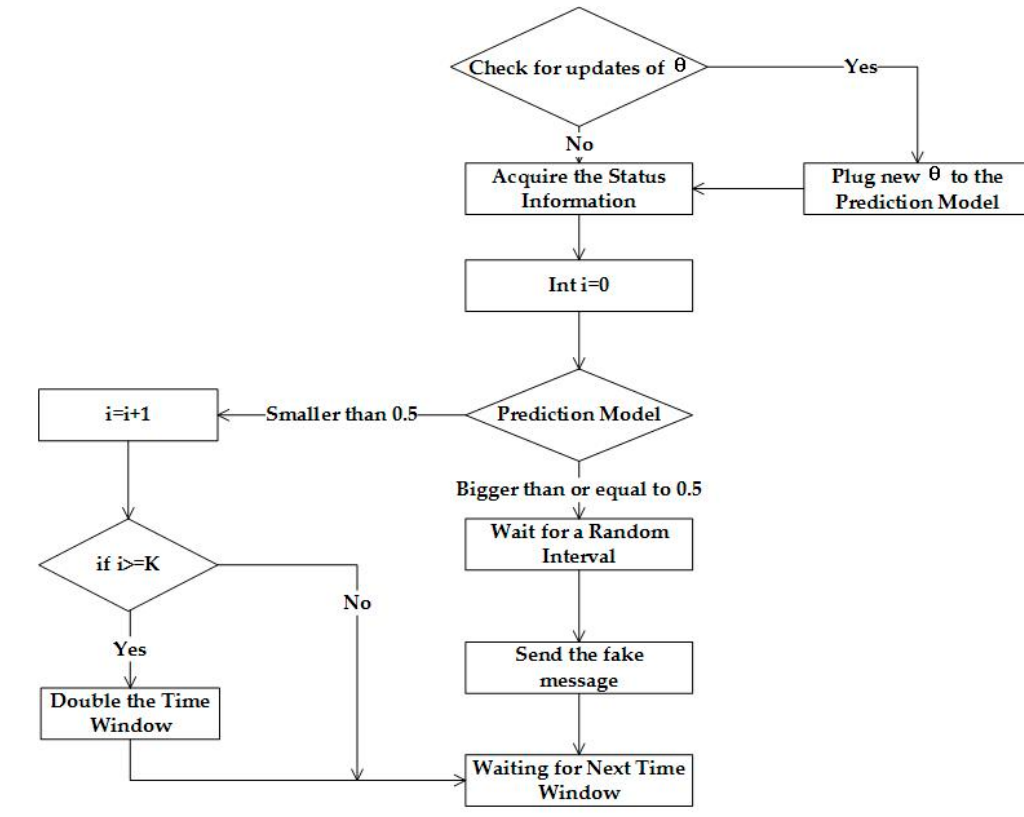
Figure 5. Sensor node determines whether or not to send fake messages.